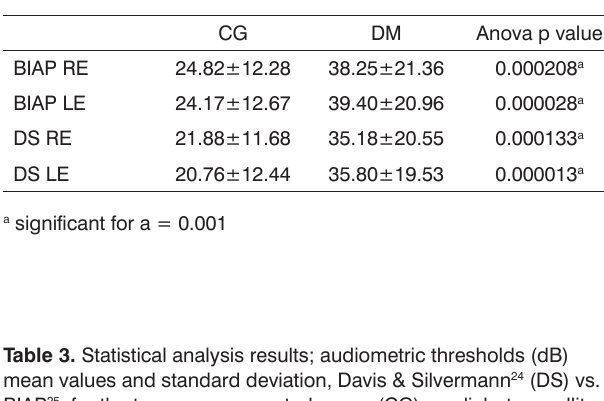
Table 2. Statistical analysis results; audiometric thresholds (dB) mean values and standard deviation according to Davis & Silver- mann 24 (DS) and BIAP 25 for the two groups - control group (CG) vs. diabetes mellitus group (DM).